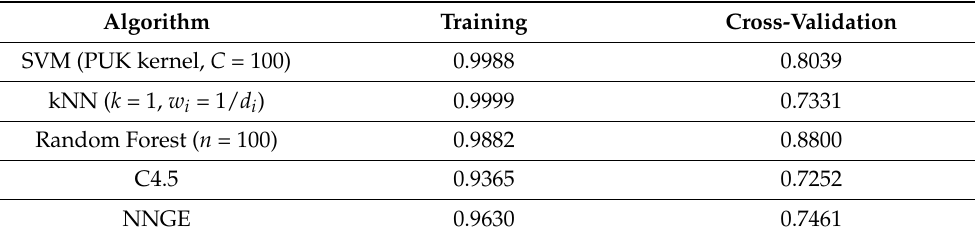
Table 3. Results of classification algorithms to predict the MD parameter based on glaucoma risk factors.